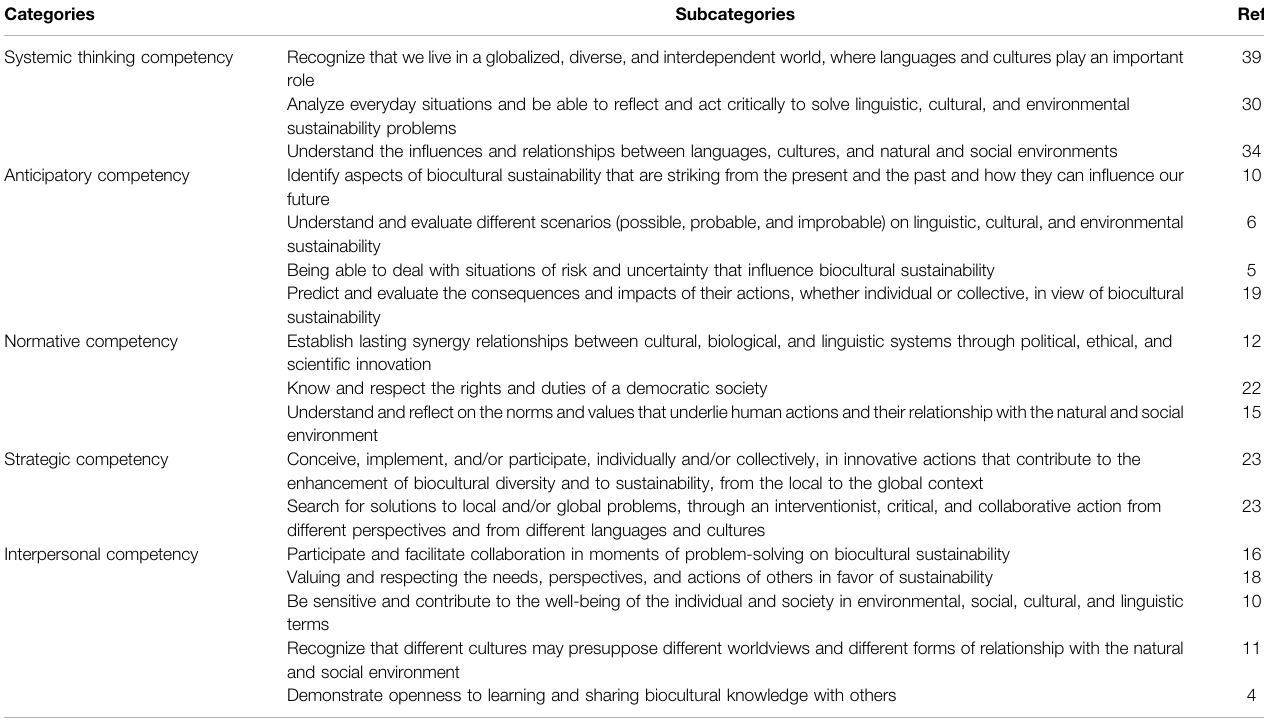
TABLE 5 | Categories and subcategories of